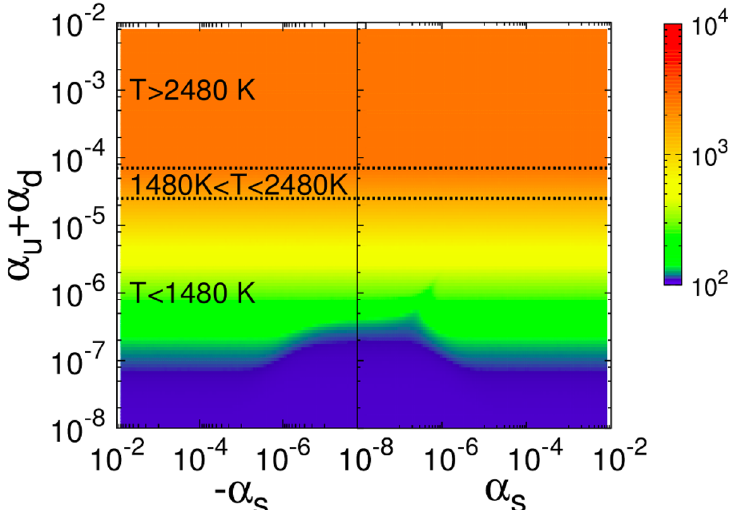
Figure 12 . T obs (in K) in the vector portal DM framework by varying (cid:11) s and (cid:11) u + (cid:11) d , while (cid:12)xing (cid:11) u = (cid:11) d , (cid:3) = 100 GeV and m (cid:31) = 1 GeV.